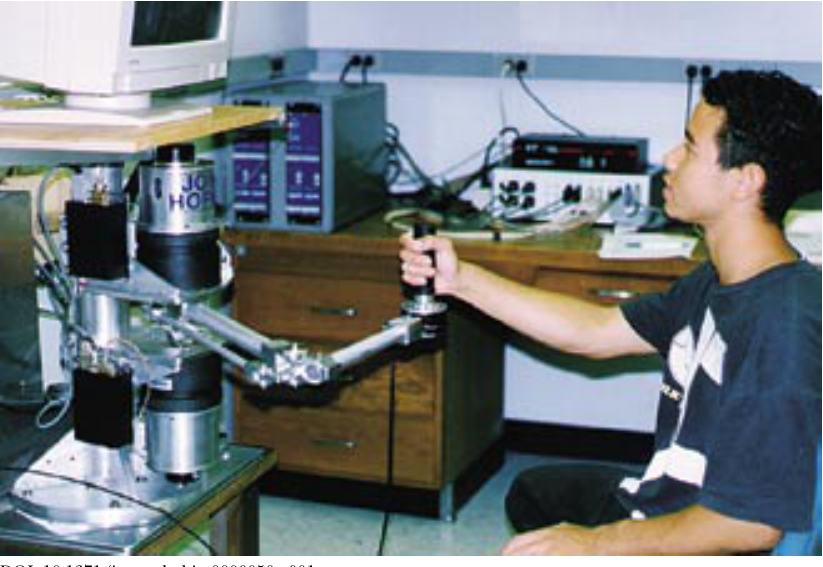
Figure 1. A Psychophysics Experiment on the Control of Reaching Movements The subject is instructed to make arm movements while holding a manipulandum, which can exert forces on his arm during the movement. The ability to adapt to such forces can give insight into the neural organization underlying movement. (Photograph courtesy of Reza